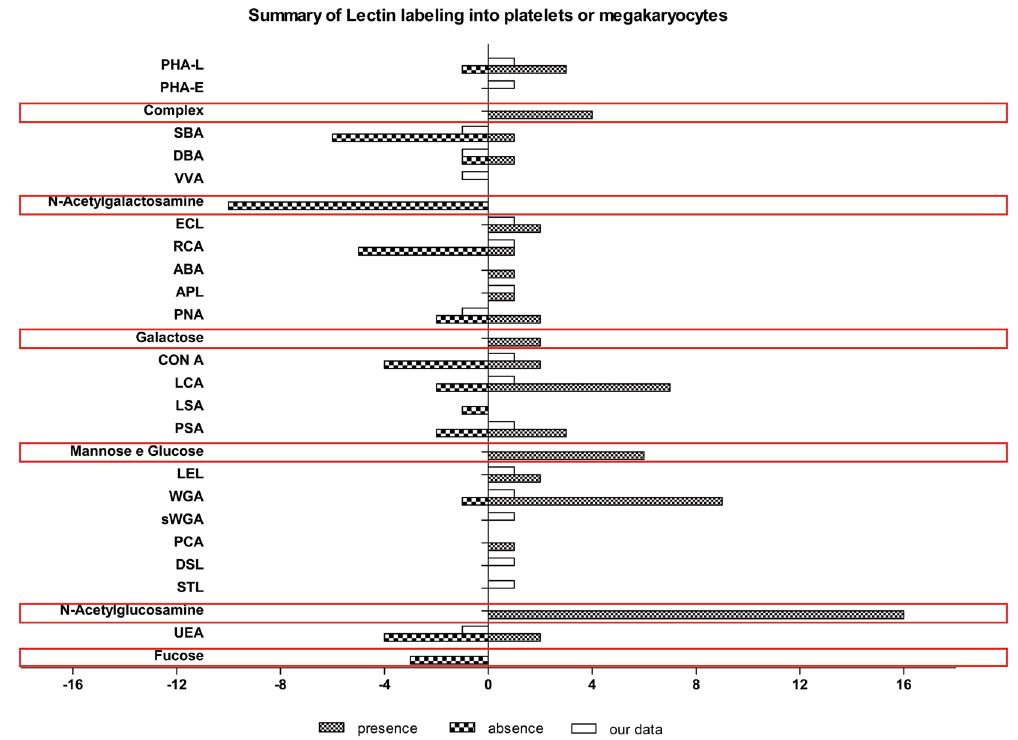
Figure 5. Summary of literature review from Suppl. Table S2 and results from this study, assembling data from humans, mouse, cats, dogs, guinea pigs from 21 lectins, also clustered by sugar recognition type as complex (PHA-E and PHA-L), N-acetylgalactosamine, galactose, mannose and glucose, N-acetylglucosamine and fucose. These clustering bars represent the final score from total absence (negative score) and presence (positive score)